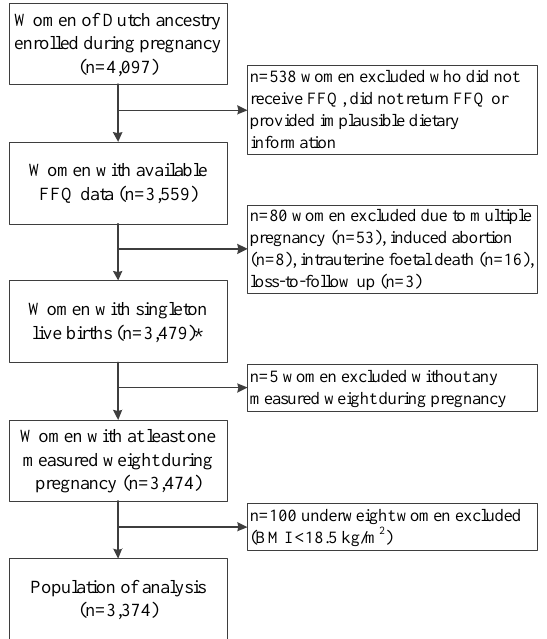
Figure 1. Flow chart of the study population: the Generation R Study (2002–2006). * Population in which the a posteriori -derived dietary patterns were determined. Abbreviations: BMI: body mass index; FFQ: food-frequency questionnaire.